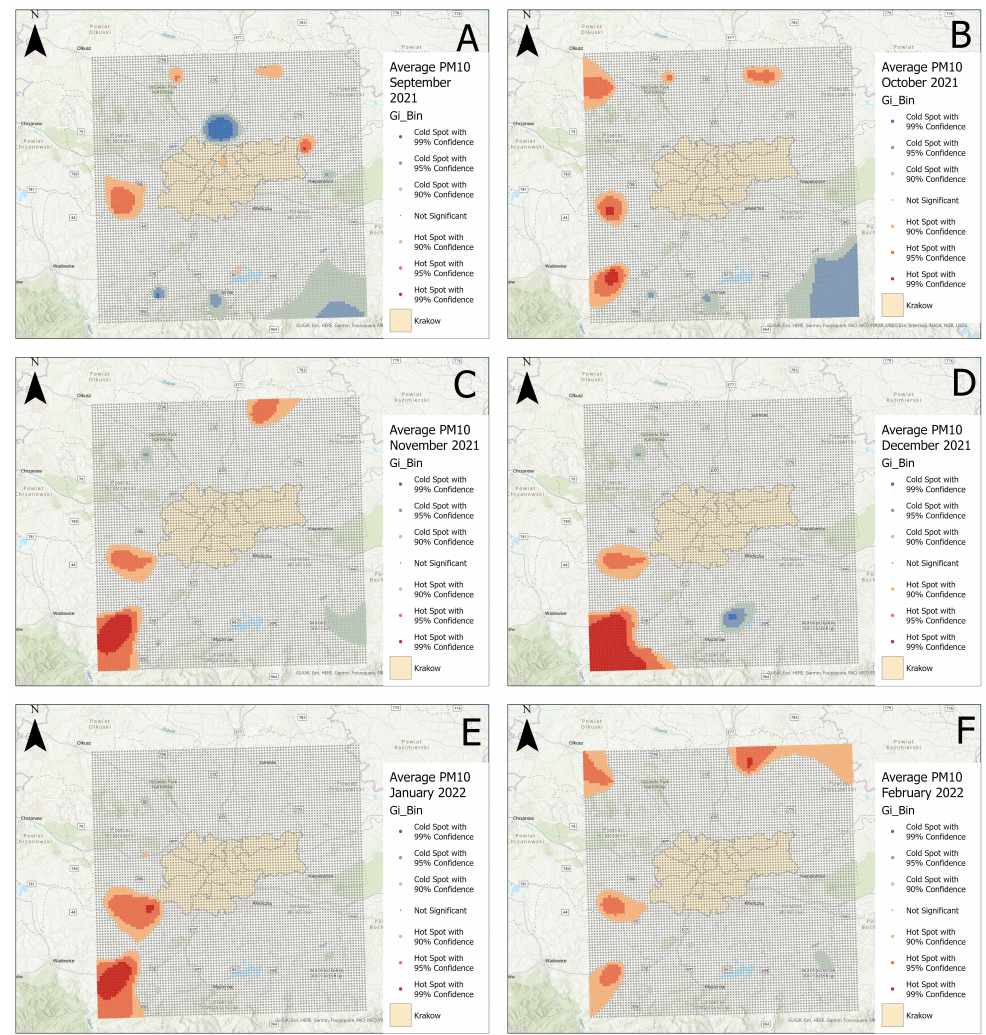
Figure 14. Hot-spots and cold-spots maps for monthly average PM10 concentration using Getis-Ord G ∗ . The maps illustrate clustering in September ( A ), October ( B ), November ( C ), December 2021 ( D ), i January ( E ), and February 2022 ( F